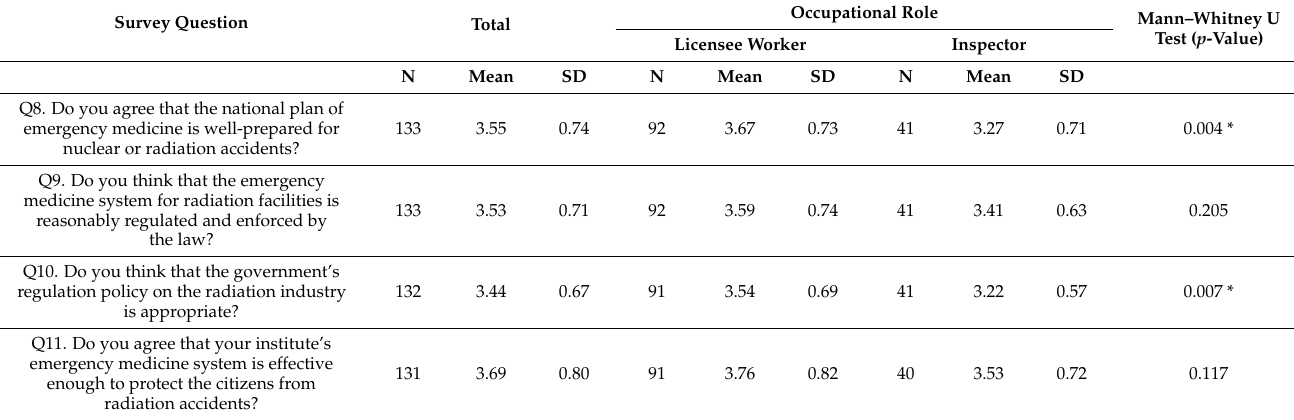
Table 3. Analysis of the surveyed responses for questions Q8~Q10 using Mann–Whitney U test.